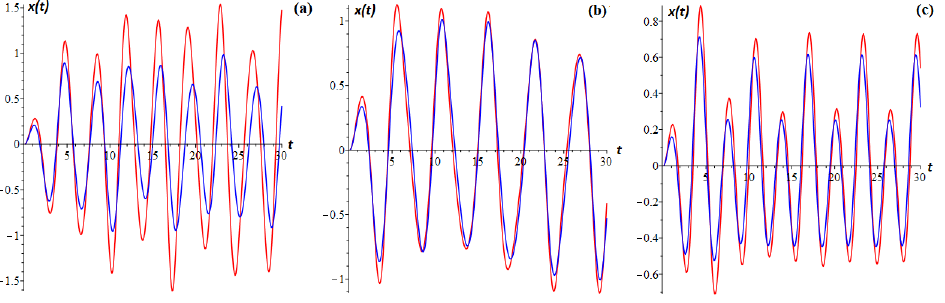
Figure 17. Waveforms for q ( t ) = 0.8cos ( 0.5 t ) at ( a ) ω = 1.2, ( b ) ω = 1.5 and ( c ) ω =